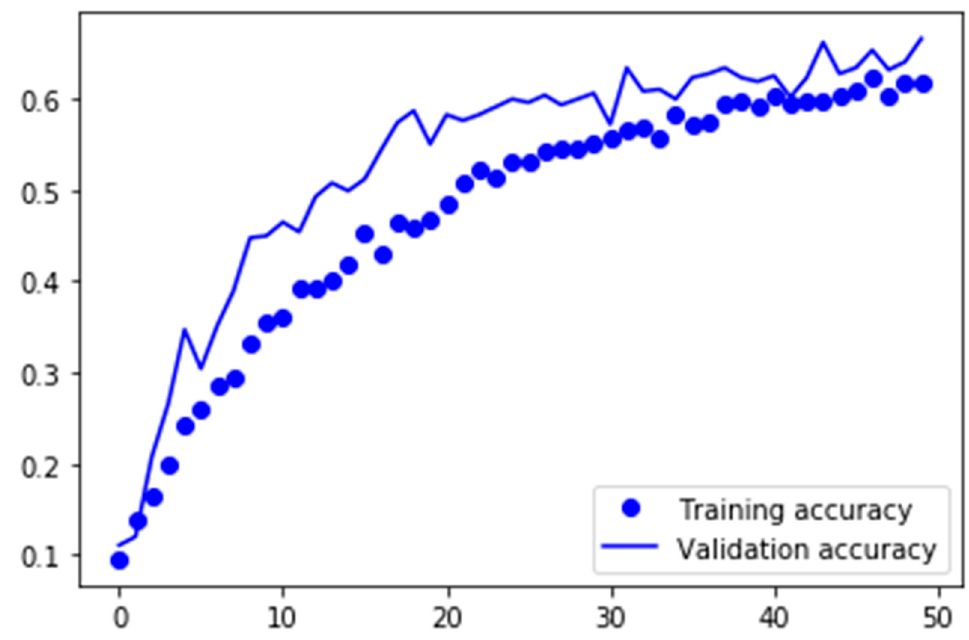
Figure 17. Training and validation accuracies over 50 epochs for transfer learning with the fashion MNIST dataset.